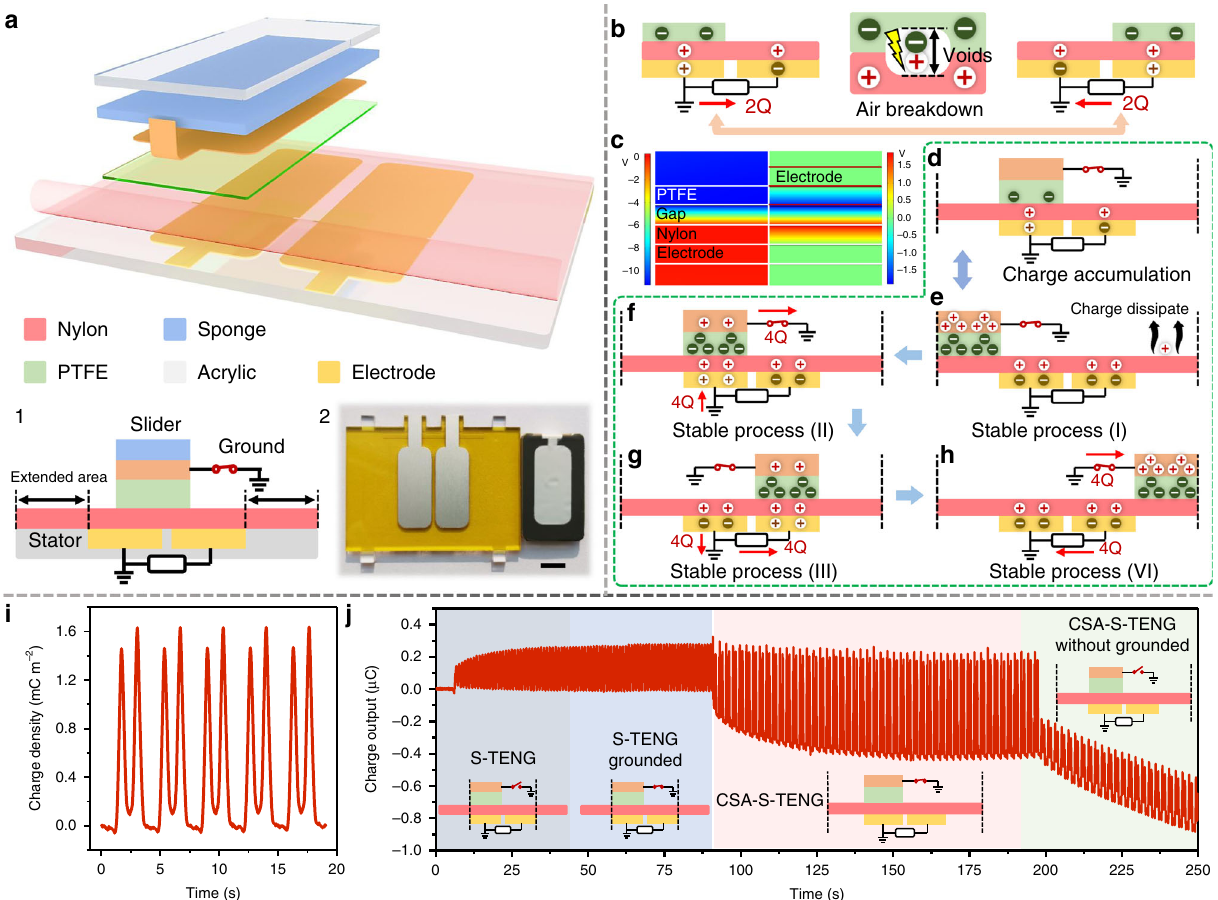
Fig. 1 Structure and mechanism of CSA-S-TENG. a The 3D schematic of CSA-S-TENG. Inset 1. Cross-section view shows the extended area structure and grounding electrode. Inset 2. Photograph of the device. The area of top electrode is 5 cm 2 . The effective area of the stationary part is 26 cm 2 . Scale bar: 1 cm. b Working mechanism and air breakdown of traditional S-TENG. c Potential simulation of air gap existence in CSA-S-TENG with/without shielding electrode. d Schematic of CSA-S-TENG with the same charge distribution as traditional S-TENG in the initial stage. e Stable charge distribution of CSA-S- TENG after multiple sliding cycles; charge generated on extended area dissipates into air, due to that there is no back electrode below to bound charge. e – h Working mechanism and relative charge transfer quantity of CSA-S-TENG in four states during half working period. i The output charge density curve of CSA-S-TENG. j Dynamic output charge curve under four working